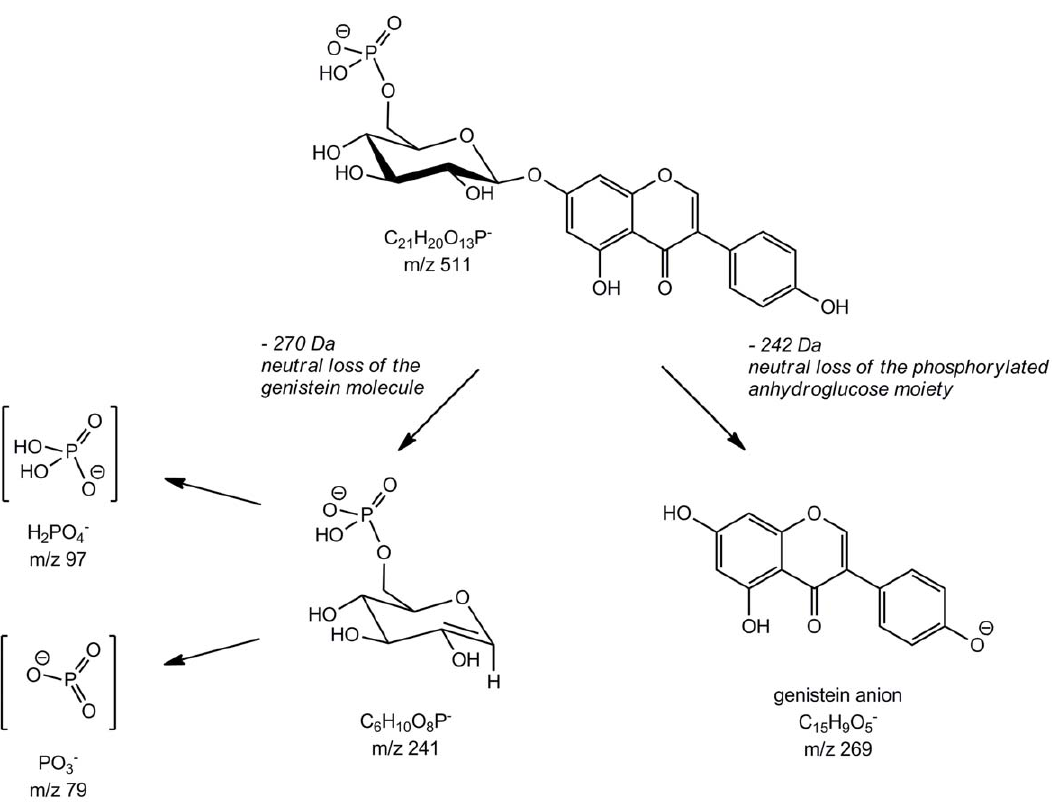
Figure 5. Fragmentation pathway of the main metabolite M5 assumed as genistein-7- O -(6 0 - O -phospho)-ß-D-glucoside.